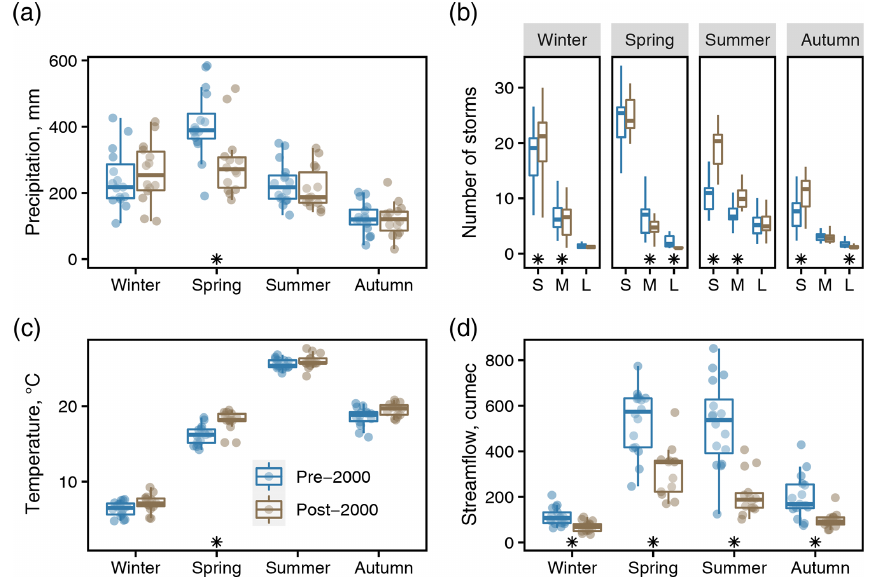
Figure 5. Seasonal climate and hydrology in the pre-2000 (1984–1999) and post-2000 (2000–2013) periods, including (a) the mean seasonal gauge precipitation and (b) the mean number of storms in PERSIANN grid cells for small (2–7.4mm), medium (7.4–18.6mm), and large ( ≥ 18.6mm) events. (c) The mean gauge temperature and (d) the mean streamflow in cubic meters per second (cumec; m 3 s − 1 ) at the watershed outlet (gauge v; Baramulla station). Statistically significant differences are noted by the asterisk ( ∗ ) when the 95% bootstrapped confidence intervals exclude zero. Notably, spring exhibited dramatic changes in temperature ( + 1.9 ◦ C) and precipitation ( − 117mm). The number of small storms increased across all seasons, while large storms decreased in all seasons except summer.